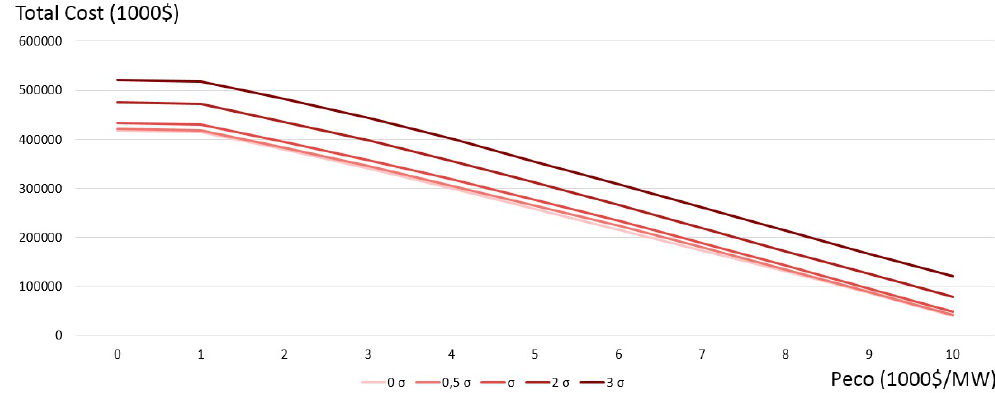
Figure 13. Variation of the optimal total cost with respect to P eco and σ in case of gamma distribution (own results).